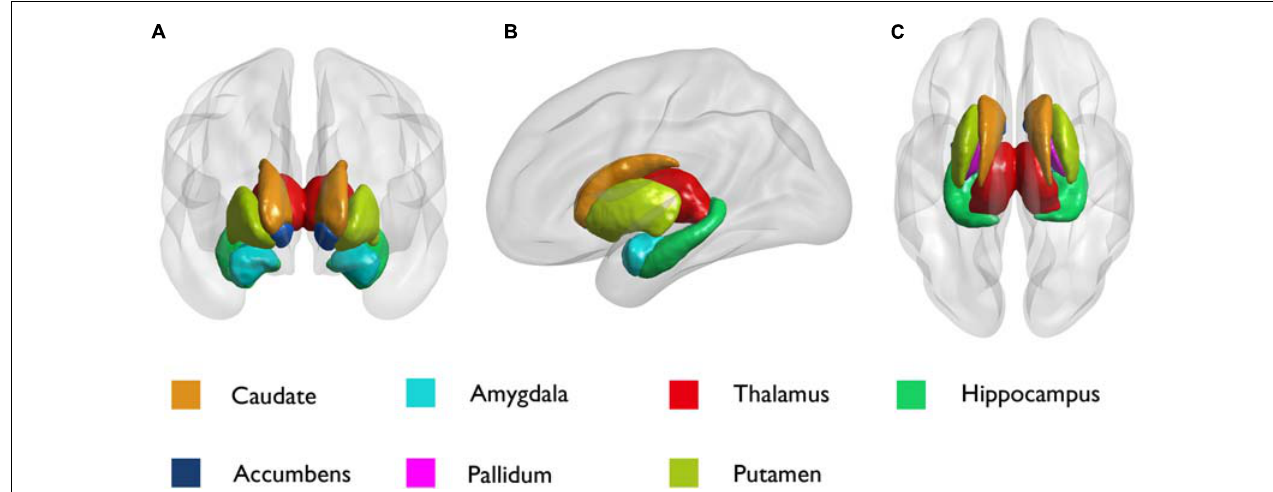
FIGURE 2 | Schematic diagram of subcortical structures by the BrainNet Viewer. (A) Coronal; (B) sagittal; and (C)